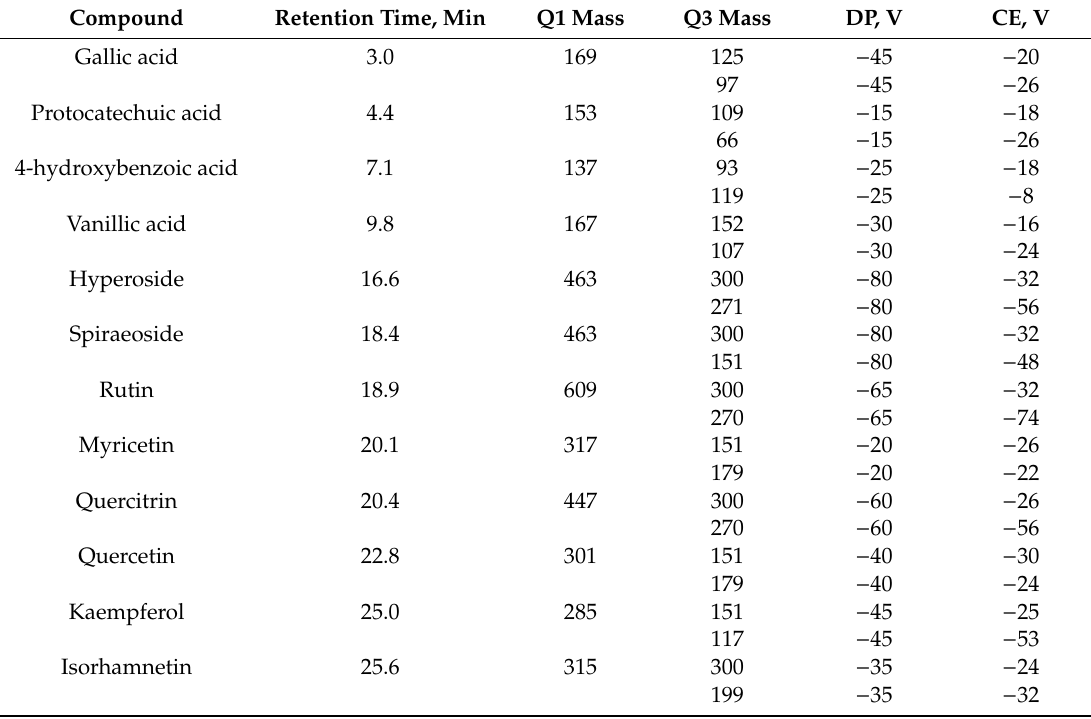
Table 1. LC-MS / MS characteristics of phenolic compounds in the negative